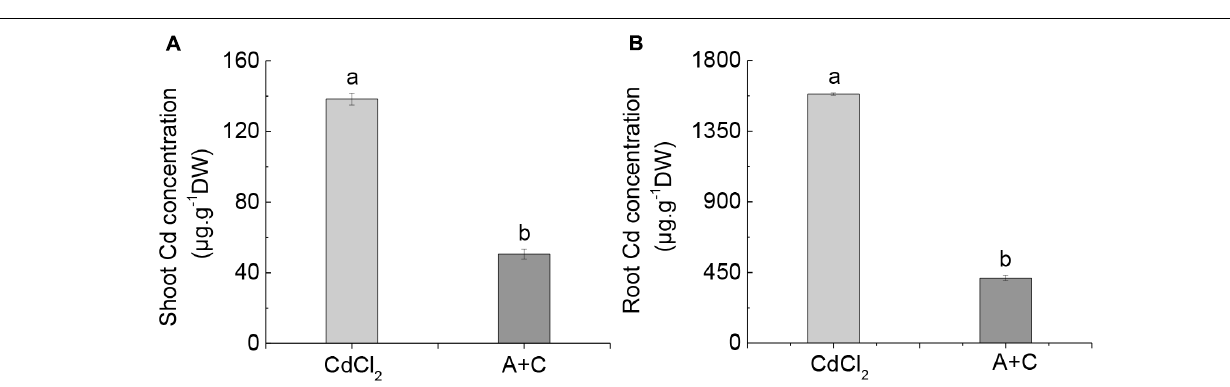
spectrometry (ICP-MS, ELAN DRC-e, PerkinElmer, Shelton, United States) as described in Huang et al. (2012), with the corresponding